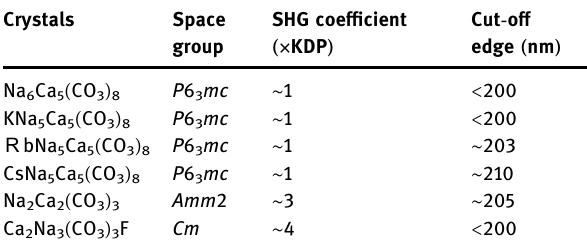
Table 2: Optical properties of alkali metal - alkali earth